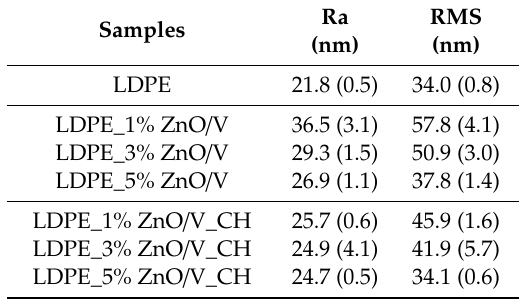
Table 1. The average values of the surface roughness (Ra, RMS) evaluated from the AFM measurements of the LDPE plate surfaces. Standard deviations are provided in